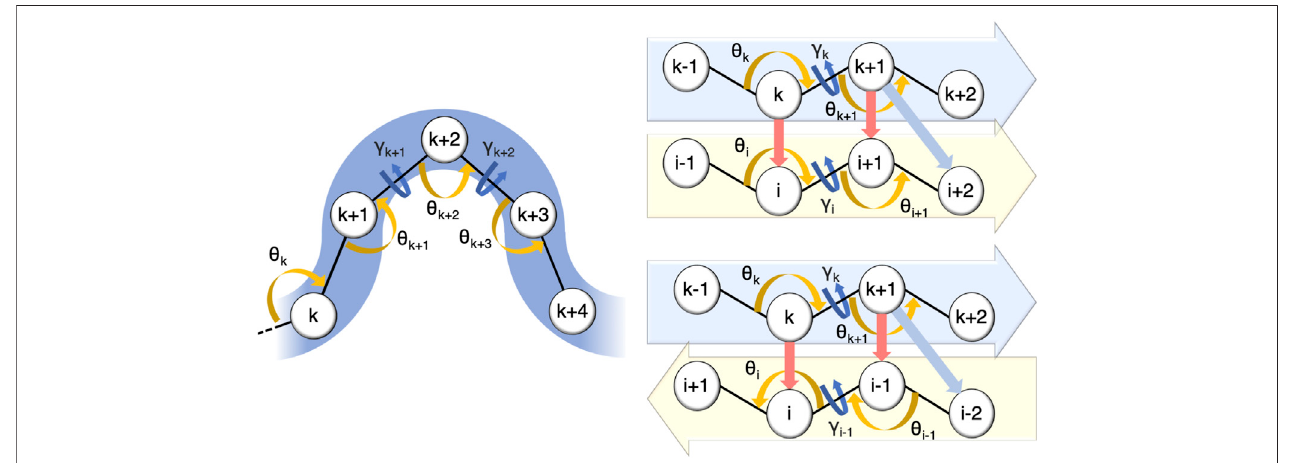
FIGURE 1 | Parameters de fi ning residues pertaining to a helix and to a parallel or to an anti-parallel β -sheet in CUTABI (see text). The spheres represent the positionsof C α atoms ofthe residues. Orange and dark-blue arrows showthe θ and c angles involved,respectively. For β -sheets,red andlight-bluearrows point outthe distances between residues involved in their de fi